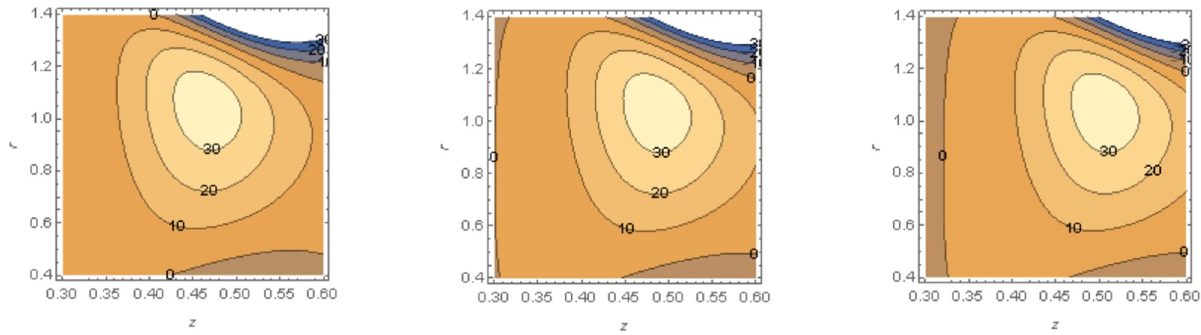
Figure 26: Various values of the wave frame streamlines of t = { 0.02, 0.04, 0.06 } at